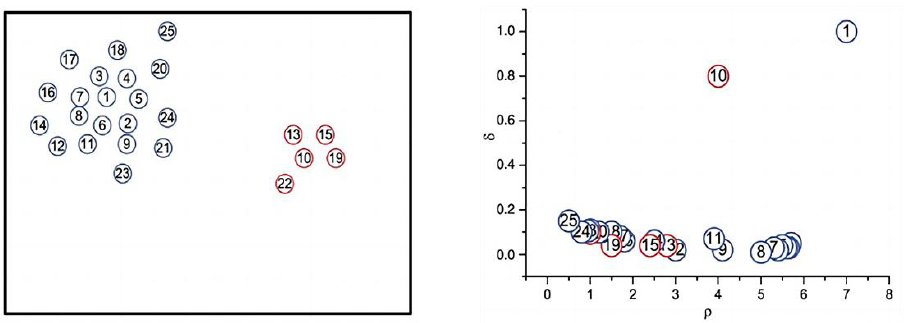
Figure 1. Determination of cluster center of density peak clustering.